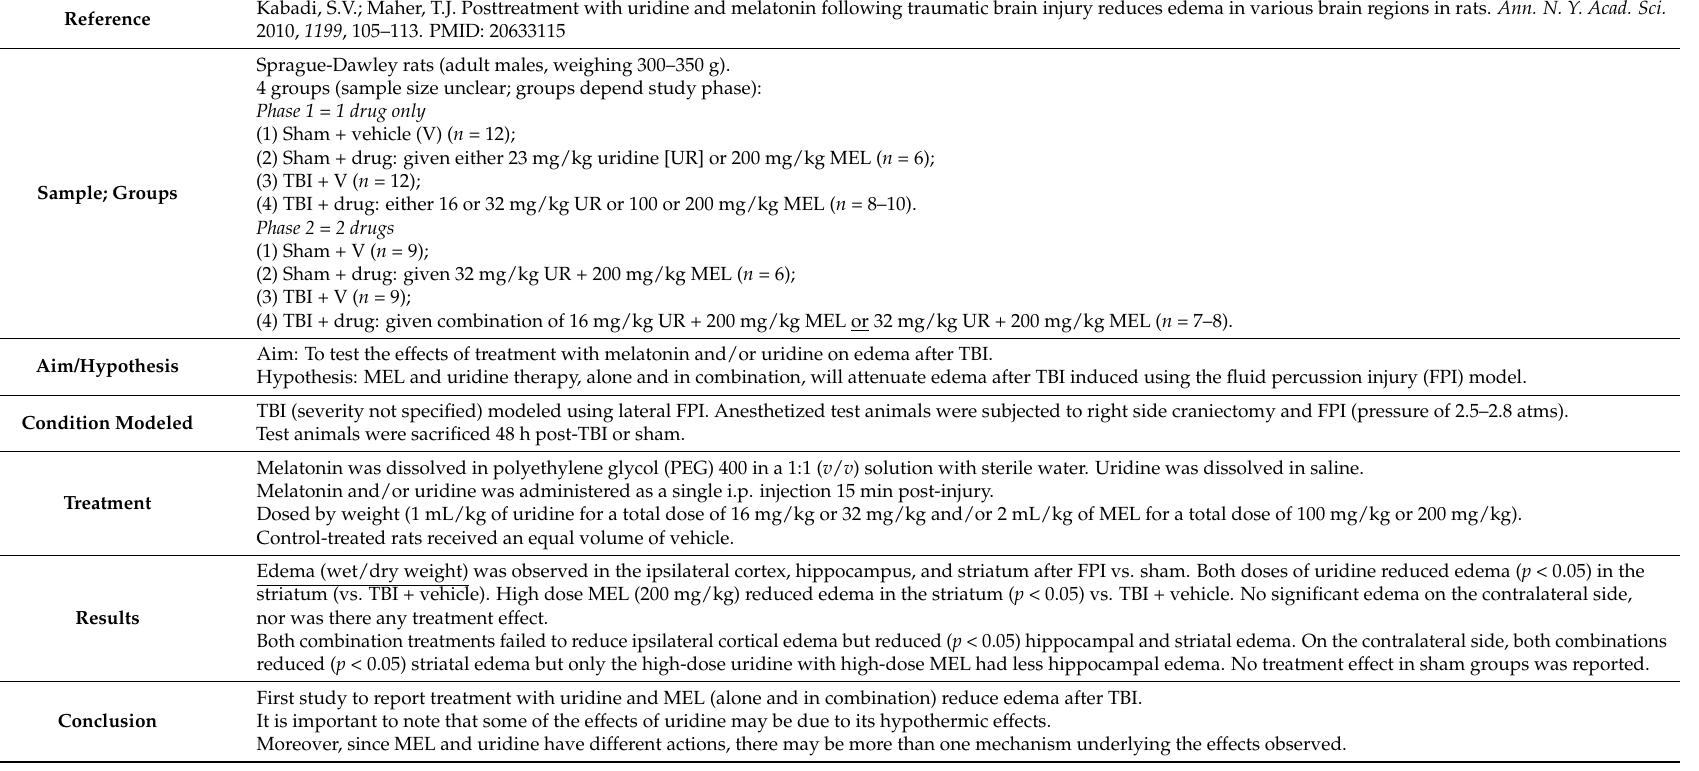
Table A10. Kabadi et al. (2010) Study